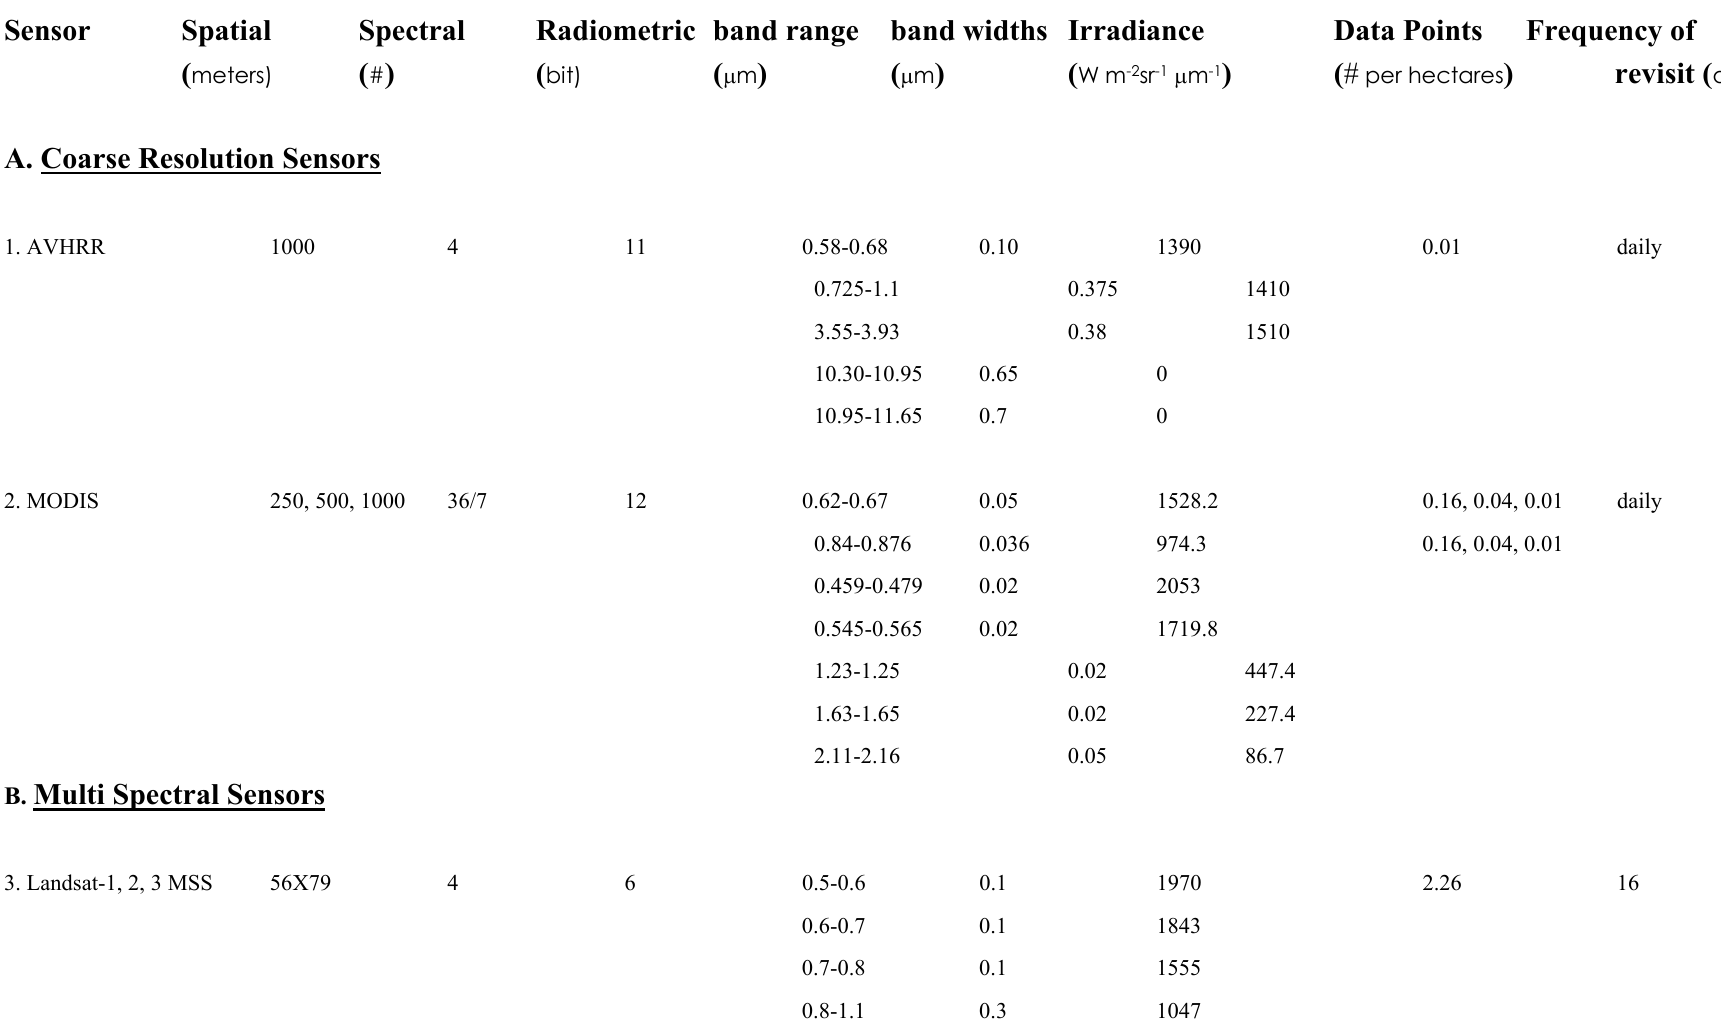
Table 1. Satellite sensor data